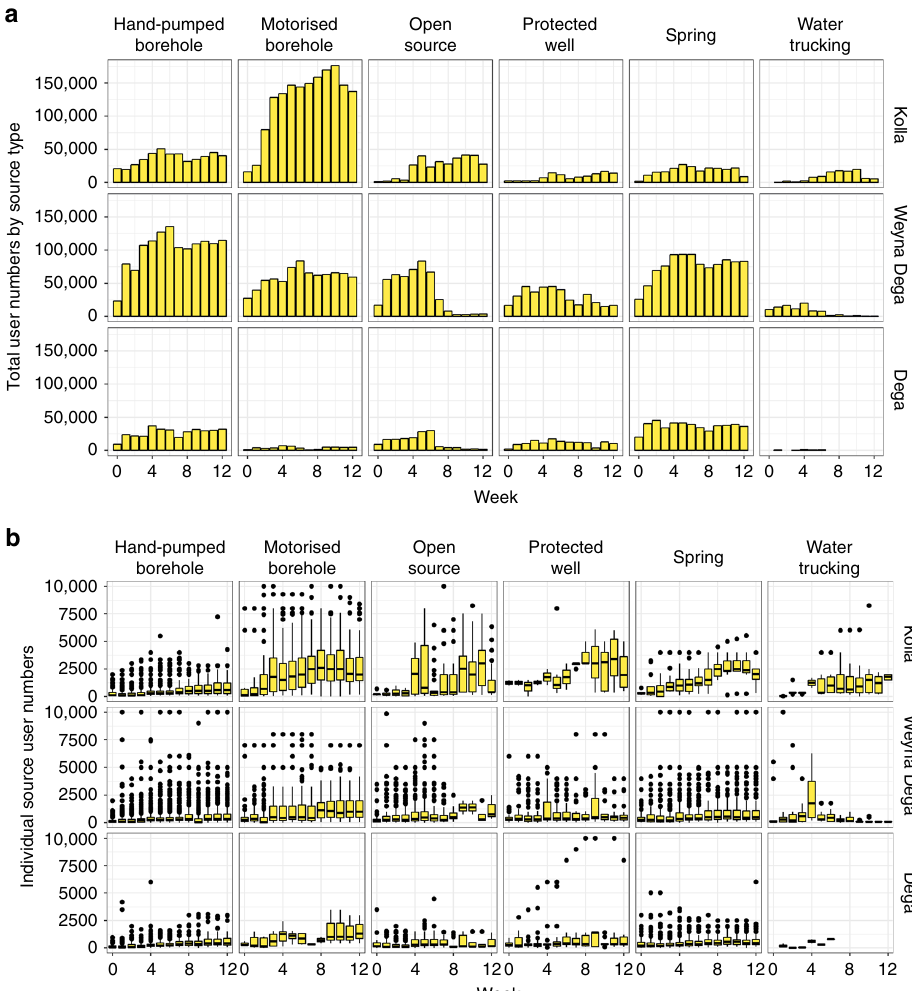
Fig. 4 Reported user numbers by water source type. a Total user numbers for each water source type in Ethiopia ’ s three altitude zones. b User numbers for individual sources in each of Ethiopia ’ s three main altitude zones for each water source type. The interquartile range is shown by the upper and lower bounds of the yellow box, the median is represented by the black line in the yellow box, the whiskers represent the interquartile range times 1.5 and the points represent outliers. Supplementary Figure 7 provides details on the numbers of each source type visited in each region and for which estimated user numbers are